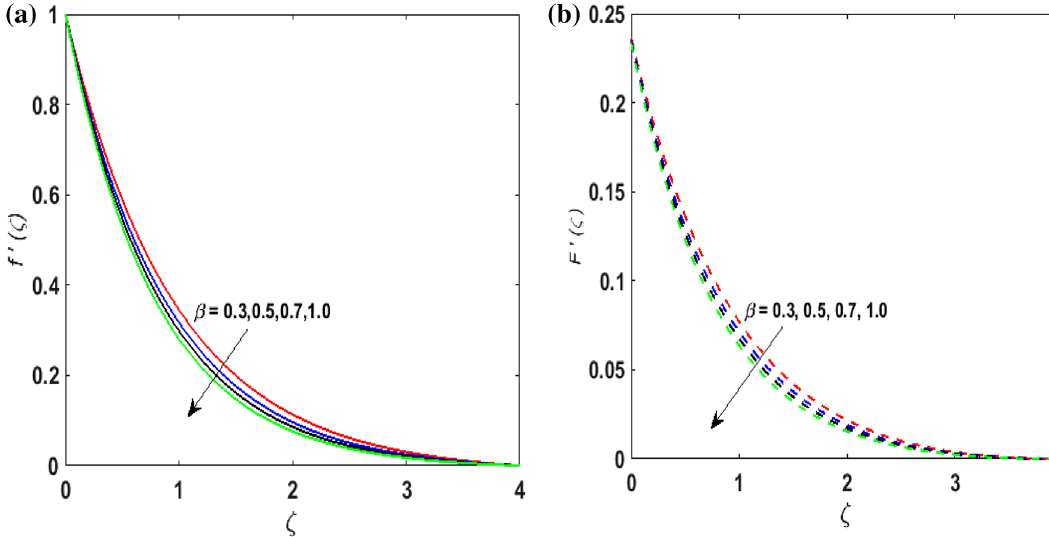
Figure 2. ( a ) f ′ (ζ) for various β . ( b ) F ′ (ζ) for various β .